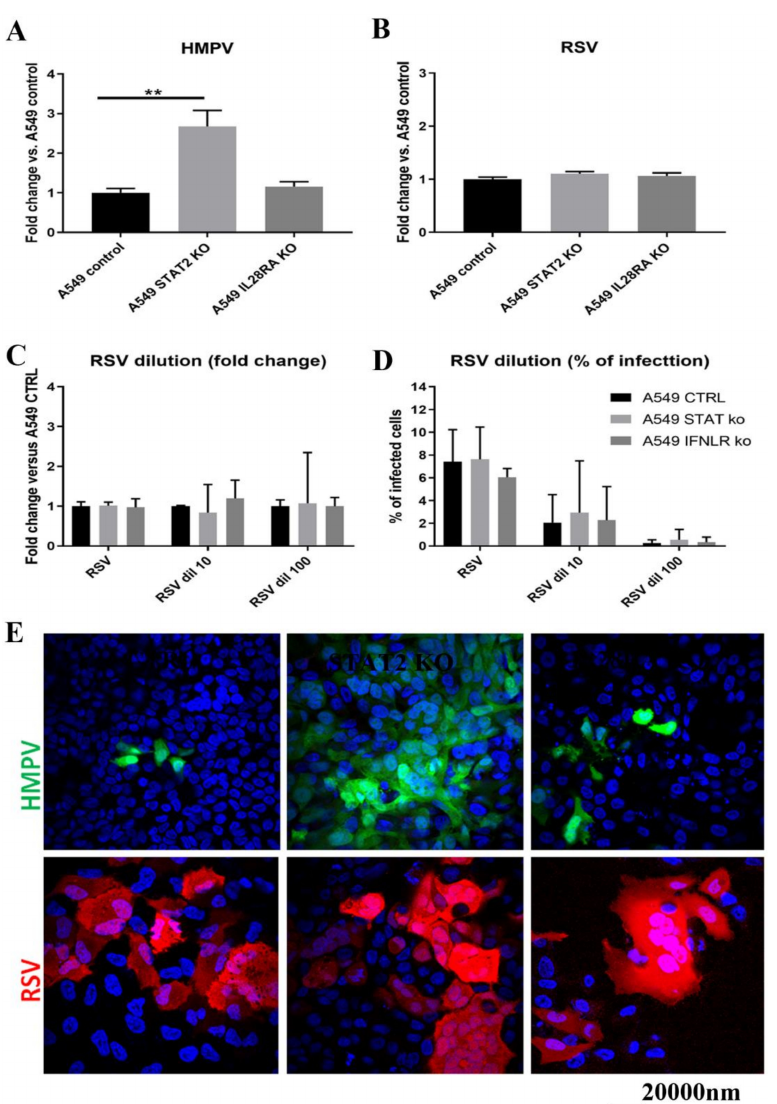
Figure 5. HMPV but not RSV replication increased in A549 cells in the absence of STAT1. A549 CTRL, STAT1 KO, and IL-28RA KO were infected by RSV and HMPV (MOI around 0.04). The percentage of HMPV ( A ) and RSV ( B ) infected cells was represented relative to A549 CTRL. RSV replication was also determined from A549-derived cells infected with RSV as in A and B and diluted 10 and 100 folds were represented in fold change relative to A549 CTRL from each inoculum concentration ( C ) and in the percentage of infected cells ( D ). ( E ): Confocal microscopy images of A549-derived cells infected with HMPV (green, upper panel) and RSV (red, lower panel). Nuclei were stained by DAPI (blue). Statistical significance calculated using two-way ANOVA, N = 4, was shown (** p <